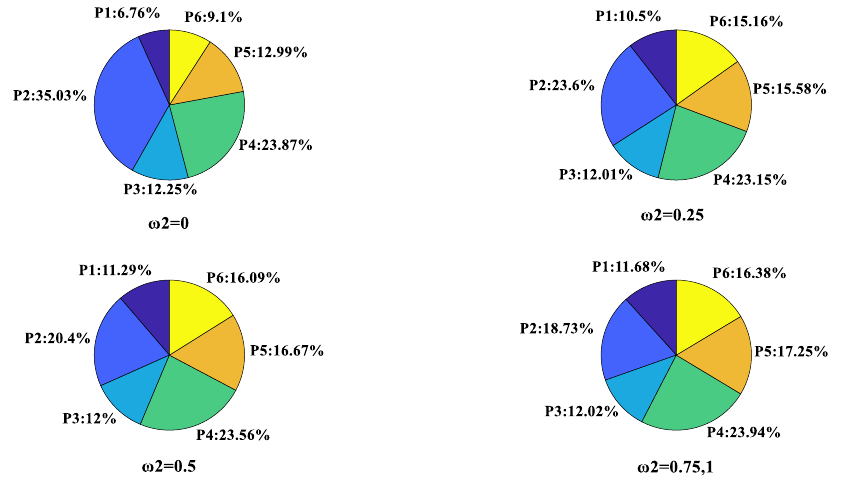
Figure 4. Proportions of power generation for different value of ω 2 .